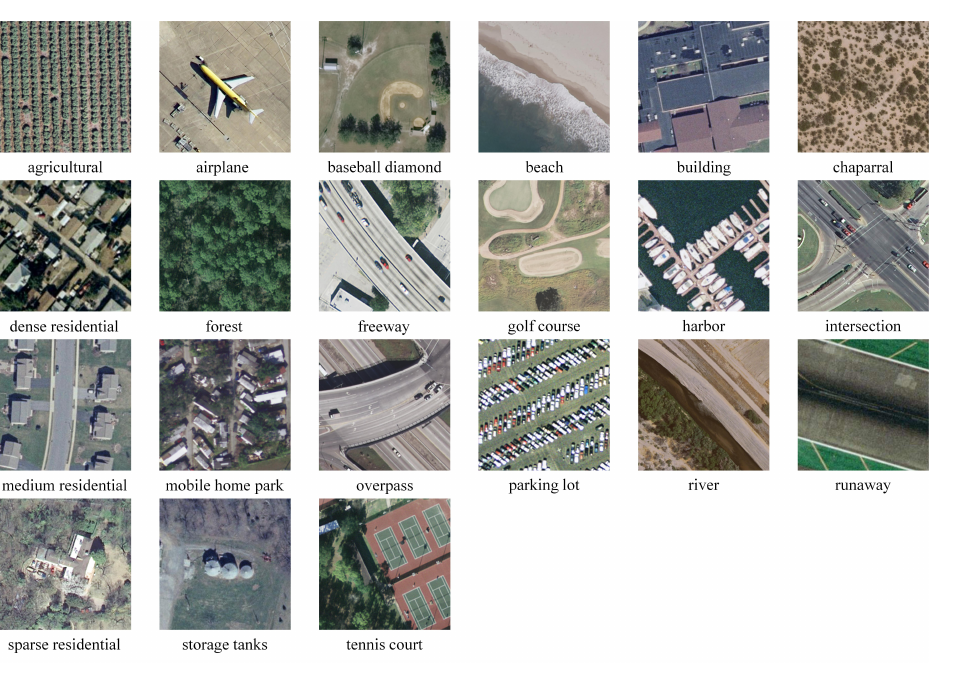
Figure 5. Some samples of the UC Merced